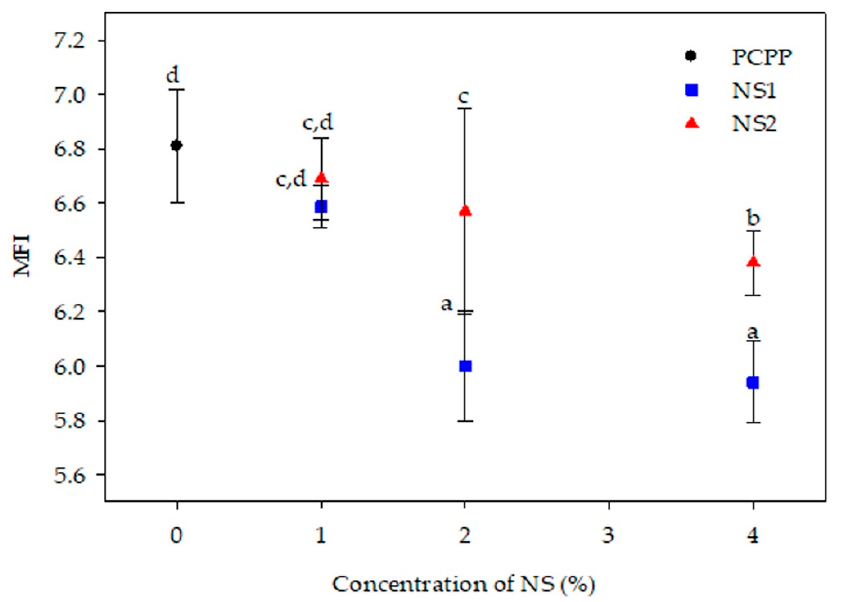
Figure 5. Melt flow index (g 10 min − 1 ) of PCPP and developed nanocomposites. Superscripts a–d indicate significant differences in MFI among samples according to ANOVA analysis and LSD Fischer’s test ( p < 0.05).